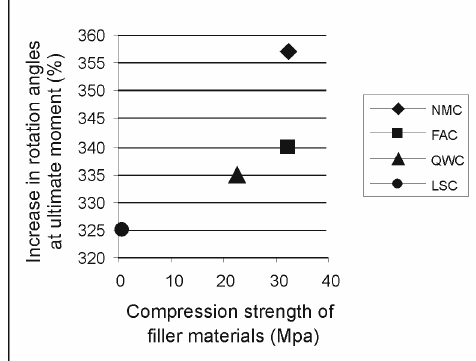
Fig. 5. Increase in rotation angles at ultimate moment